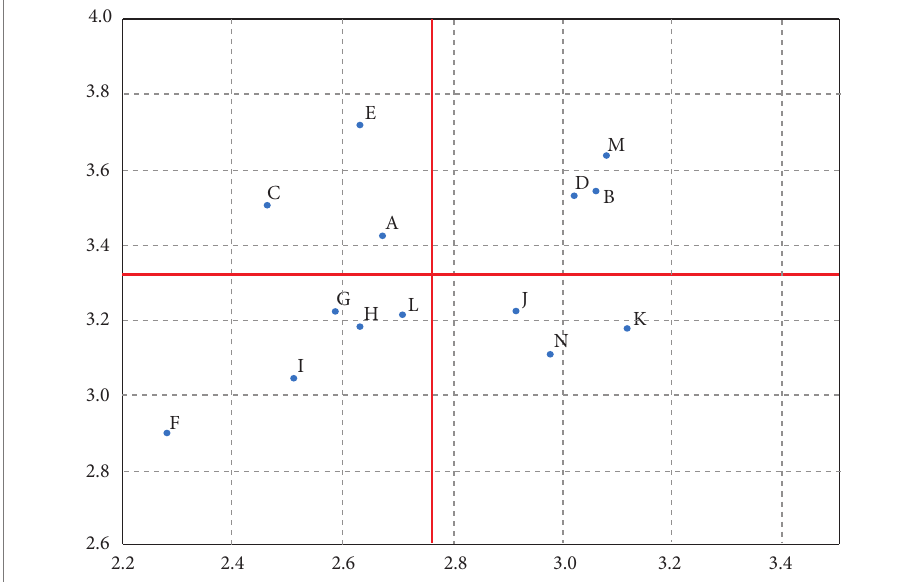
Fig. 14. The scatter diagram of parameters of relations of Ukrainian enterprises with the equipment